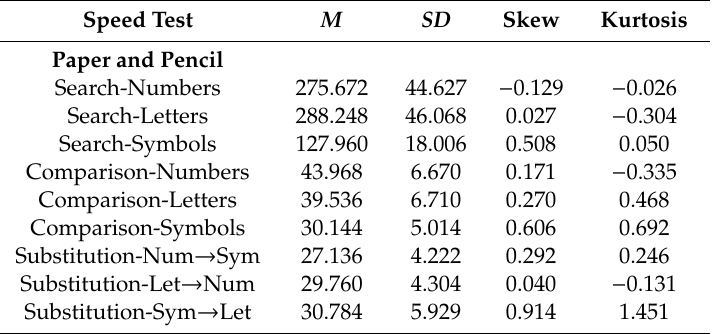
Table 1. Descriptive statistics for paper-and-pencil and computer-based speed